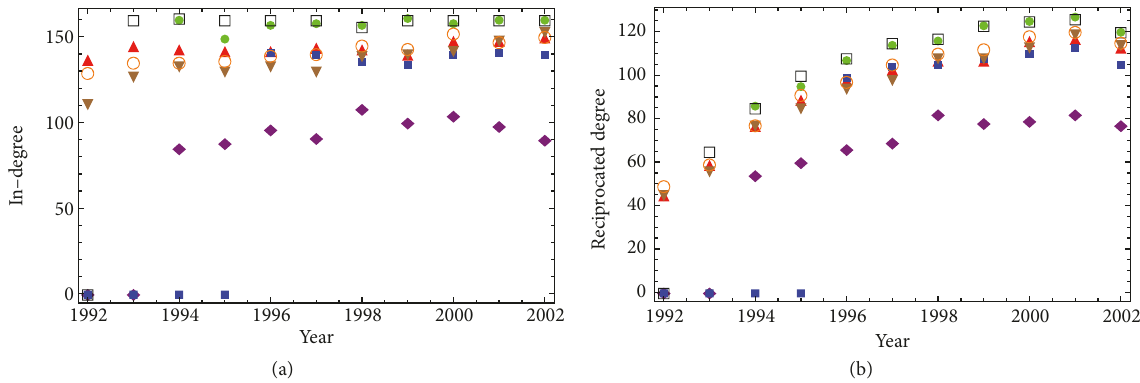
Figure 2: Dynamics of the in-degree (defined as ℎ 𝑖 = ∑ 𝑗( ̸=𝑖) 𝑎 𝑗𝑖 ) and of the reciprocated degree (defined as 𝑘 ←→ 𝑖 = ∑ 𝑗( ̸=𝑖) 𝑎 𝑖𝑗 𝑎 𝑗𝑖 ) of a sample of countries (Italy, in green; Japan, in black; China, in red; Russia, in blue; India, in brown; USA, in purple; Australia, in orange): while the in-degree remains rather stable across time, the value of the reciprocated degree keeps rising once the country has joined the SCC. Such a dynamics can be interpreted as a signal of ongoing integration [16].